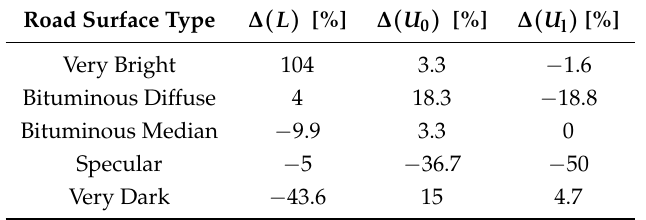
Table 9. Differences between calculated values of the selected road type and reference C2 road.